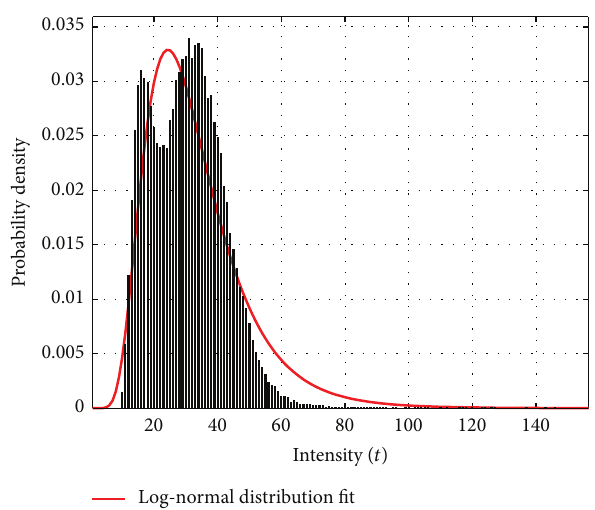
Figure 11: Normal distribution fitting.